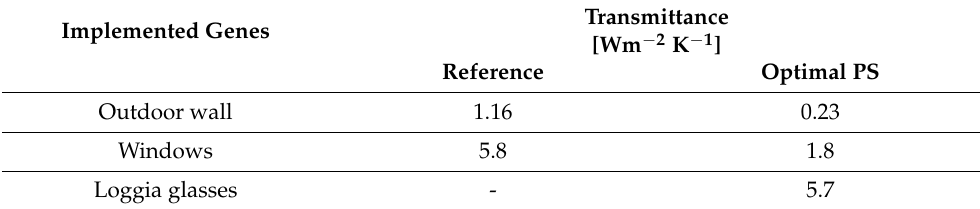
Table 5. Transmittance of the implemented genes.